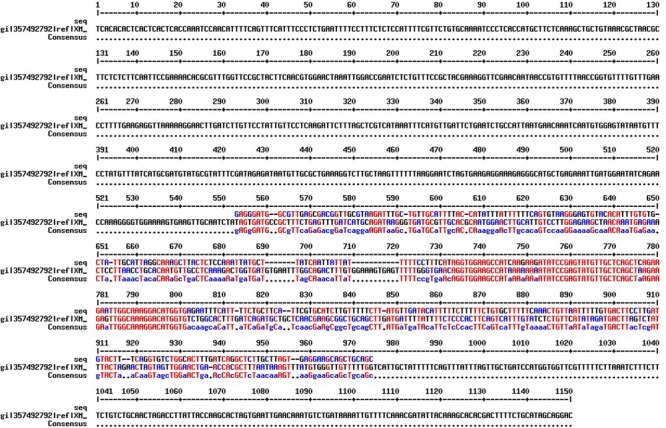
Sequence alignment between Medicago truncatula ferritin-2 full length CDS (NCBI reference no. XM_003616637.1) and lentil Ferritin-1 partial genomic sequence using the MultAlin tool (Corpet, 1988) with default parameter values. The overlapping potential exonic region (95 bp) is marked in blue and red color.